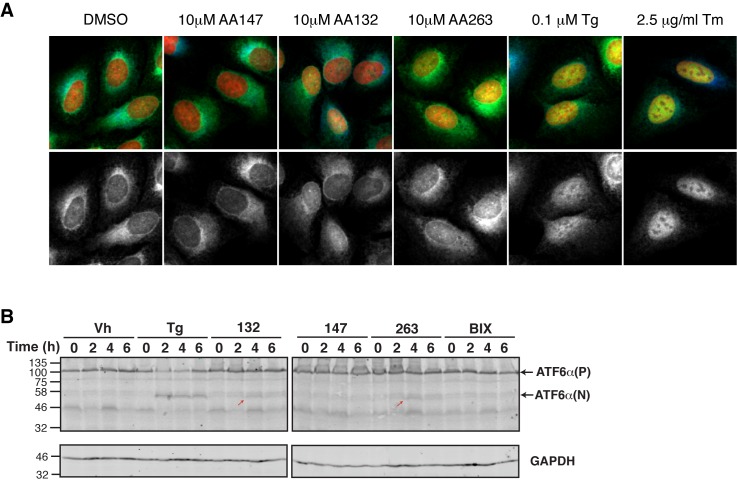
Select ER proteostasis regulators show proteolytic processing and nuclear translocation of ATF6.(A) Representative images of U2OS-GFP-ATF6 cells incubated with Tg (100 nM), Tm (2.5 µg/mL), or the indicated ER proteostasis regulators (10 μM) for 5 hr then imaged by confocal microscopy. GFP-ATF6 is shown in green in the upper merged images and in grayscale beneath. The ER is marked with GRP94 (blue) while nuclear DNA is marked with DAPI (red). Yellow in the merged image indicates translocation of GFP-ATF6 to the nucleus. Quantification of nuclear ATF6 localization from images such as these are shown in Figure 4D. (B) Immunoblot showing ATF6 processing from full-length (ATF6α(P)) to the cleaved ATF6α(N)) in HEK293T cells treated with Tg (500 nM) or 10 µM of the indicated small molecule ER proteostasis regulators for the indicated time. The small molecule BIX is included as a control. The red arrows show the active ATF6 transcription factor domain that results from S1P/S2P cleavage.